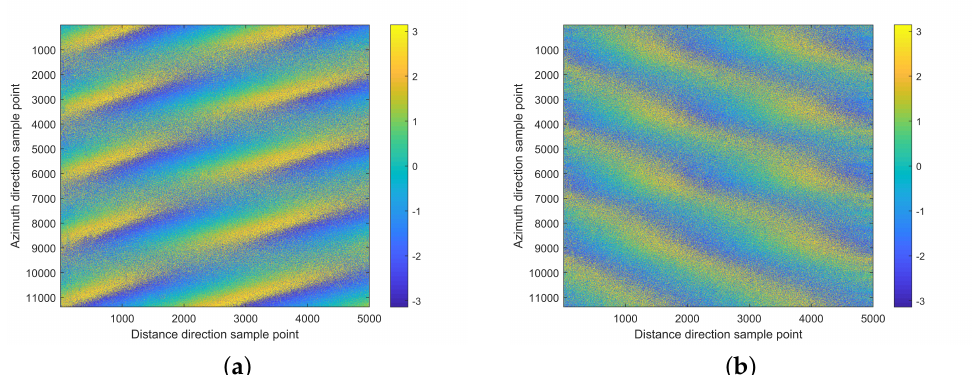
Figure 15. The comparison of interference fringe results. ( a ) The main POS imaging; ( b ) the left POS